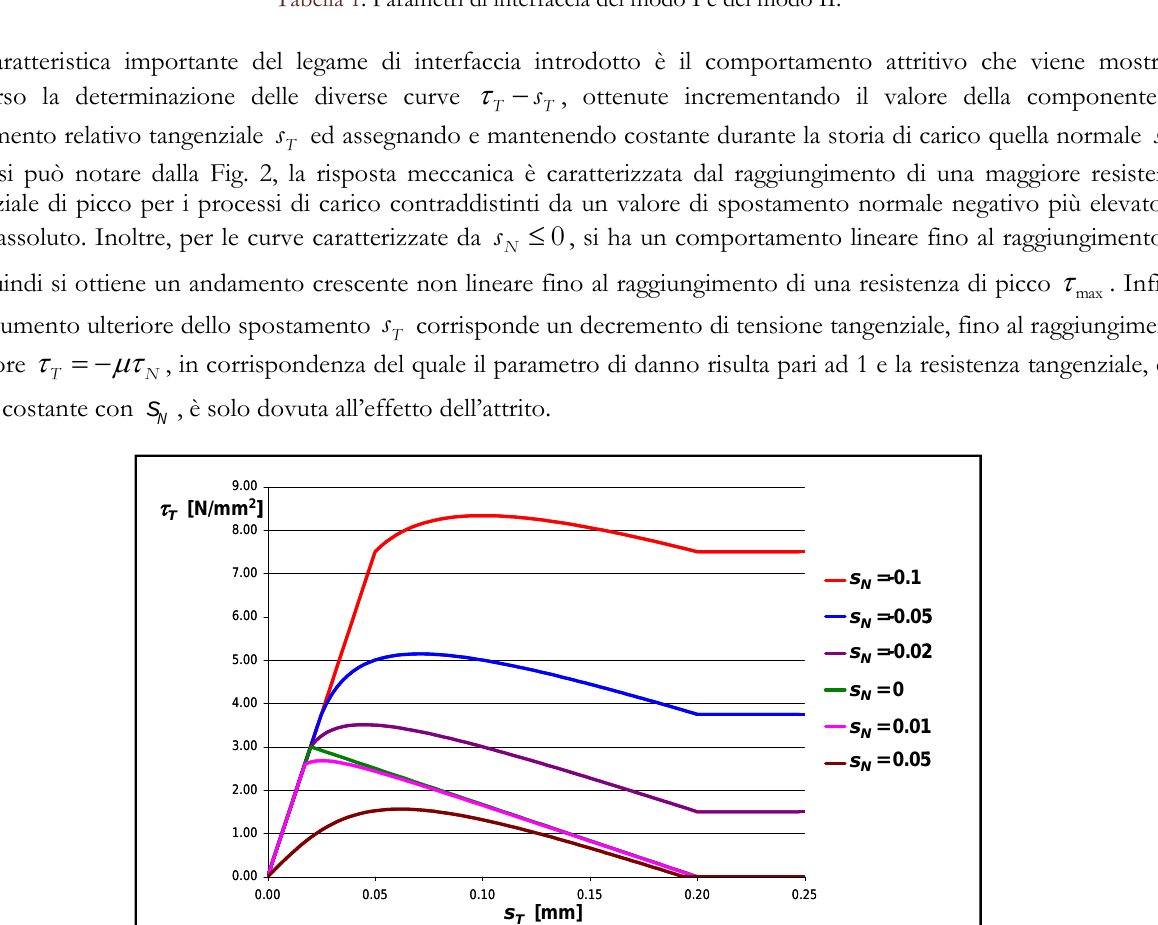
s per differenti valori di T T